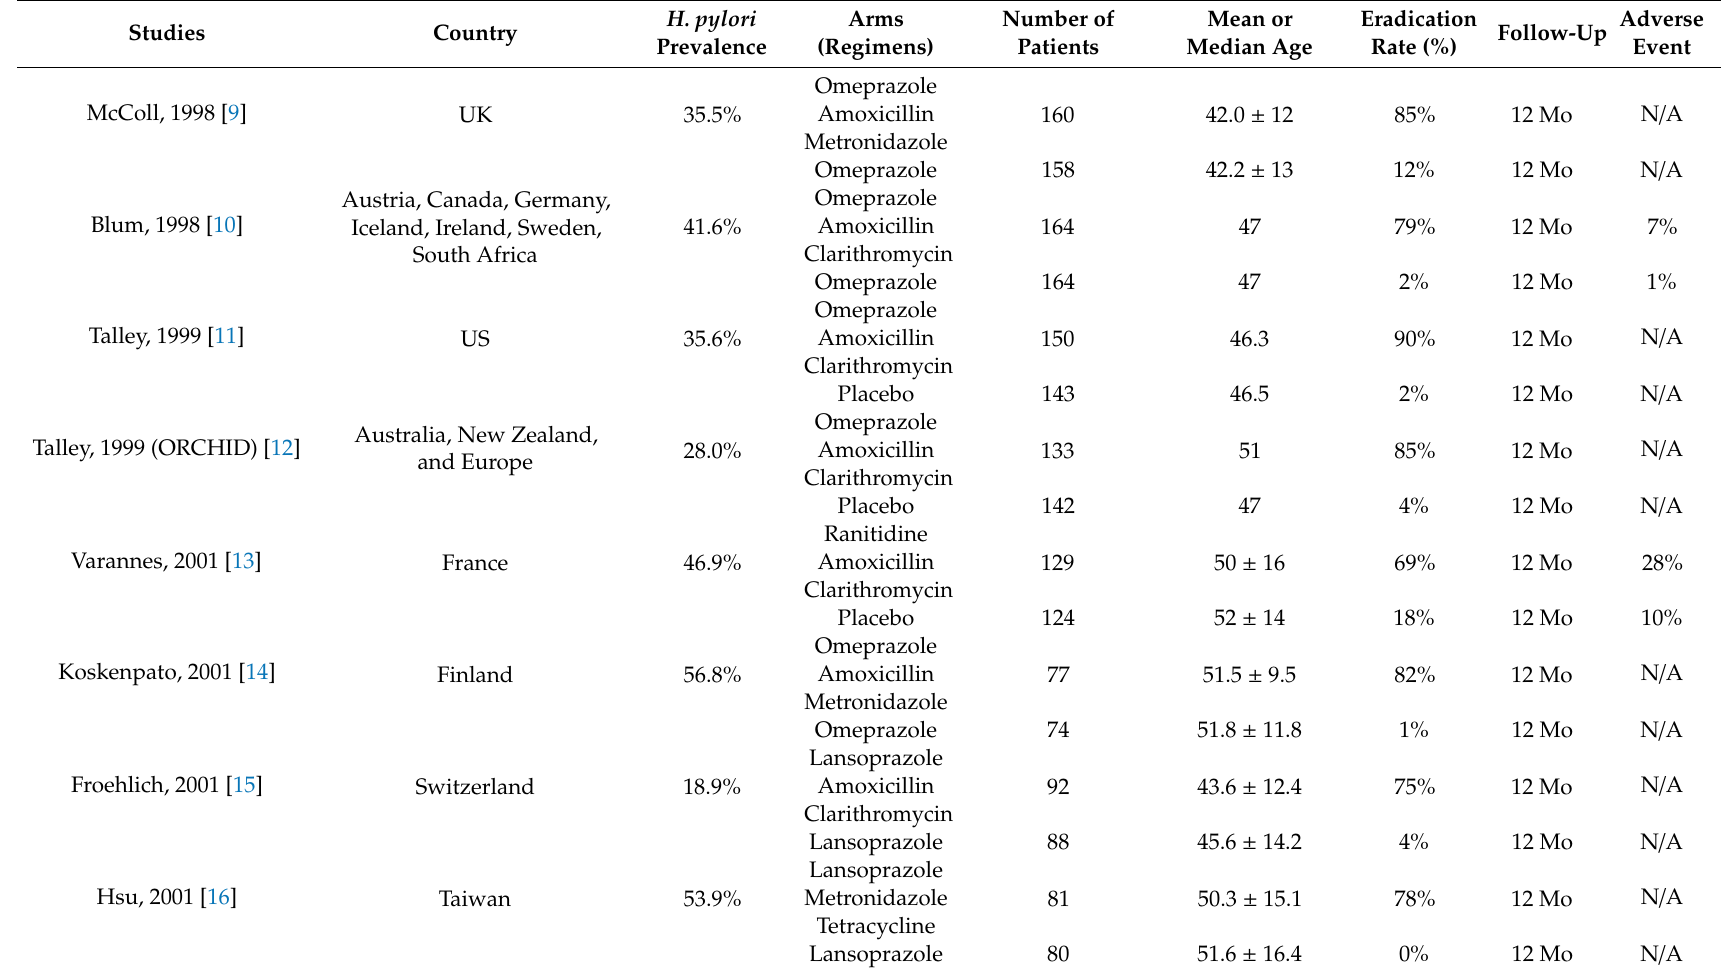
Table 1. The characteristics of the studies included in the